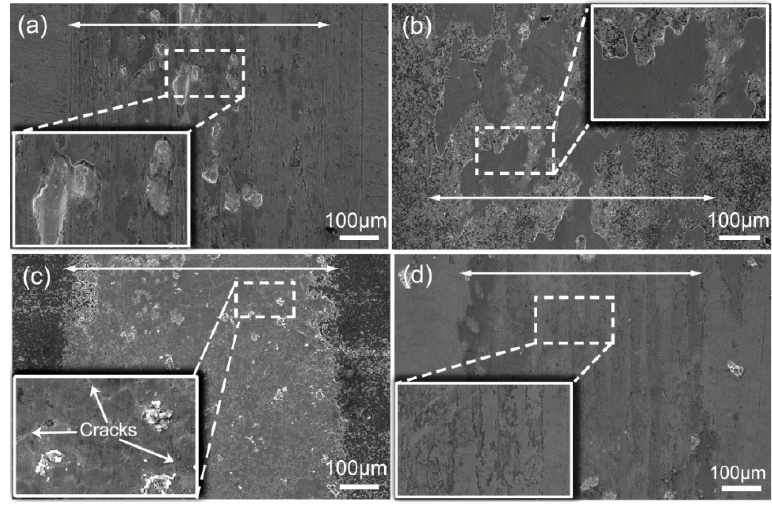
Figure 8. Wear morphologies of various samples: ( a ) starting material; ( b ) PB; ( c ) BC-1; ( d ) BC-2.